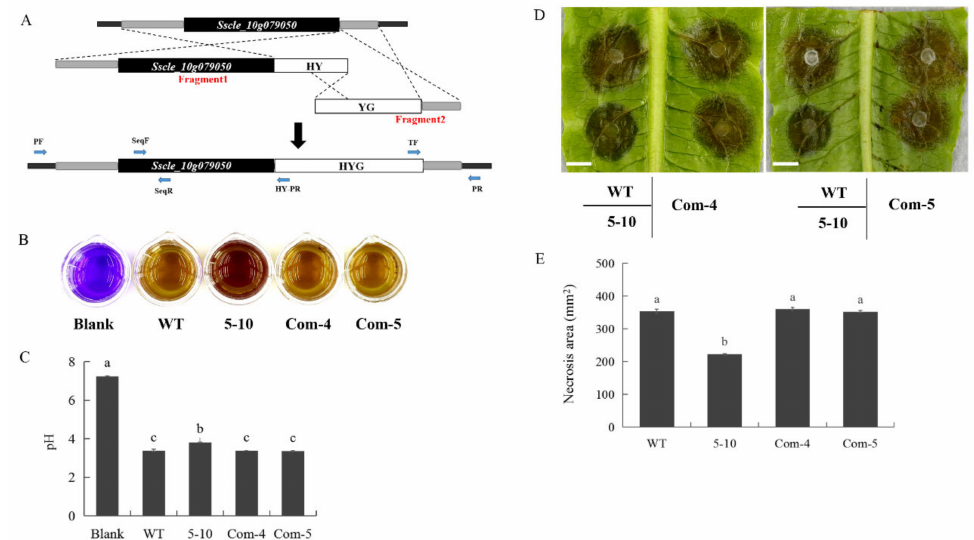
Figure 3. Transgenic complementation of the 5–10 mutant by Sscle_10g079050 . ( A ) Knock-in method illustration for targeted gene complementation in S. sclerotiorum . Fragment 1 is composed of upstream sequence of the target gene genomic DNA, and the first half of hygromycin-resistance gene (HY), and Fragment 2 is composed of the second half of hygromycin-resistance gene (YG) and downstream sequence of the target gene. Once transformed into protoplasts, the two fragments replace the target gene with wild-type genomic DNA by homologous recombination. ( B ) Color change in WT, 5–10, and Sscle_10g079050 independent transgene complementation lines (Com-4 and Com-5) grown in PDB medium containing bromophenol blue indicator 48 hpi. ( C ) pH of WT, 5–10 and Com-4 and Com-5 lines after 48 hpi in PDB medium. ( D ) Lesions caused by S. sclerotiorum infection on lettuce leaves by the indicated fungal strains. Bar = 10 mm. Experiments were conducted at least three times with similar results. Data were recorded at 36 h post-inoculation (hpi). ( E ) Quantification of lesion size of WT, 5–10, Com-4 and Com-5 lines on lettuce leaves. ImageJ was used to analyze lesion size. Error bars represent SE. Statistical significance was analyzed using Student’s t -test. a, b and c represent different significance levels.